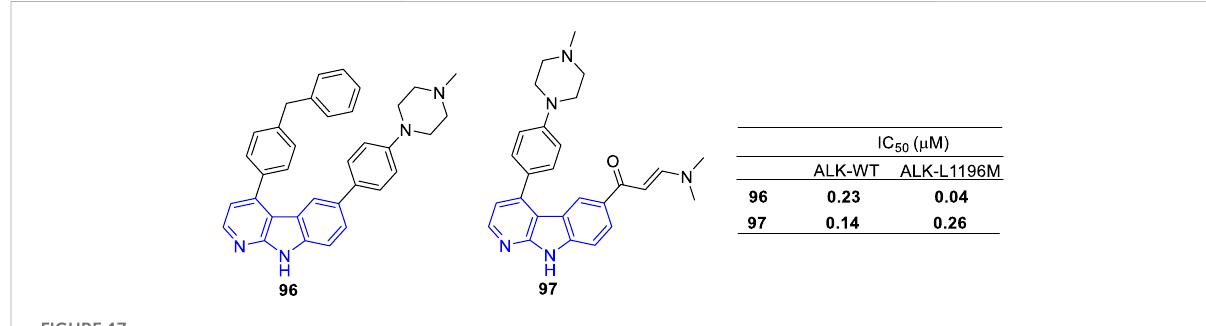
FIGURE 17 Structure and bioactivity of the representative compounds 96 and 97 .